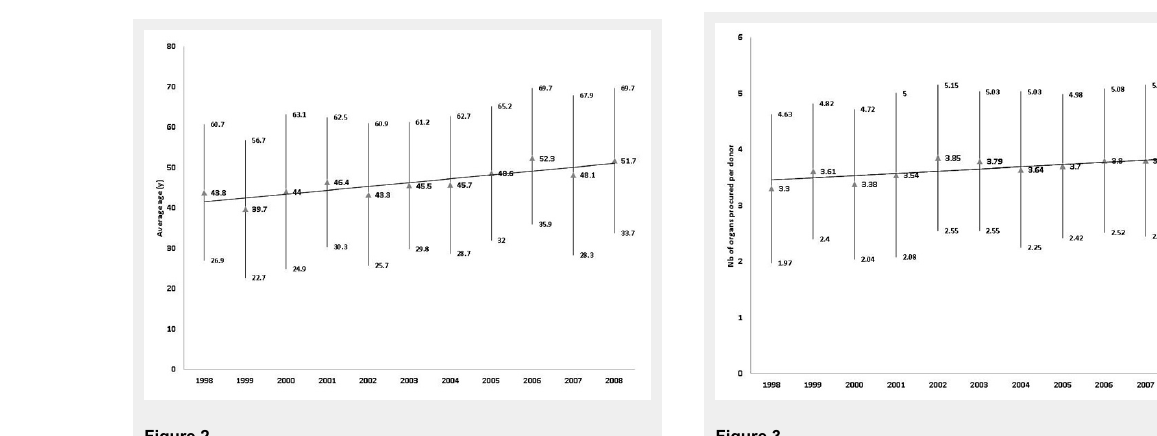
Average age (in years) of the deceased donors per year, displaying ±1.SD (standard deviation) and linear trend.